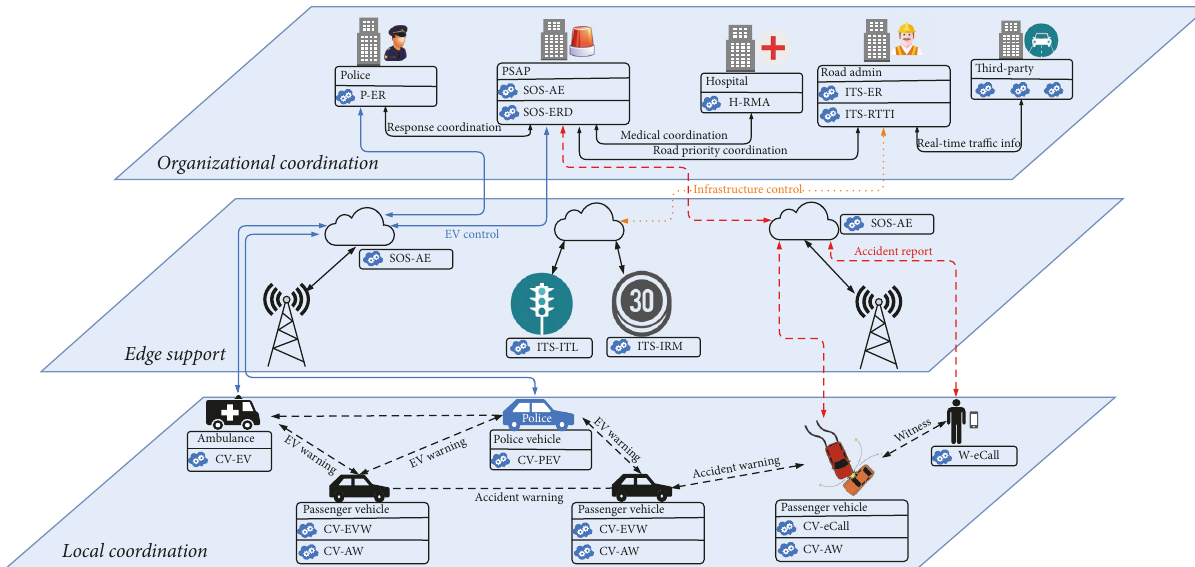
Figure 3: A layered architecture of